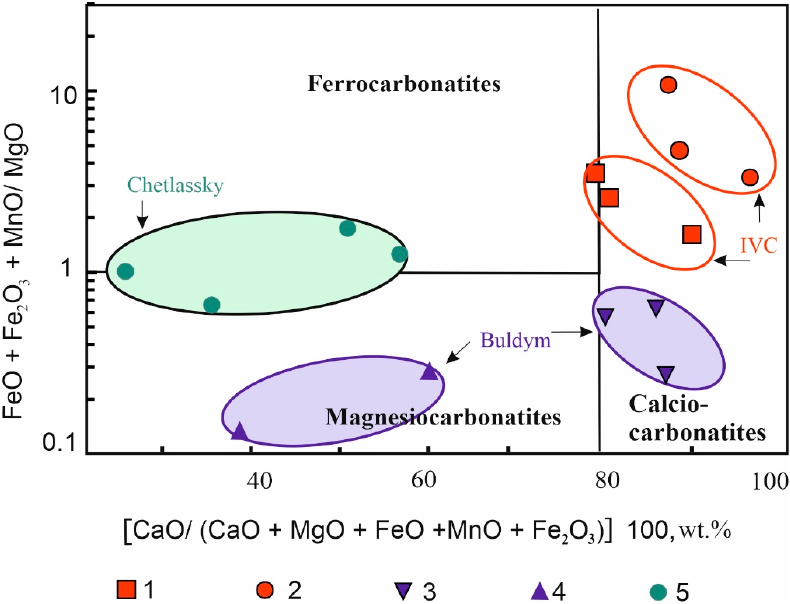
Figure 5. Compositions of the Urals and Timan carbonatites (wt %) on classification diagram [101].